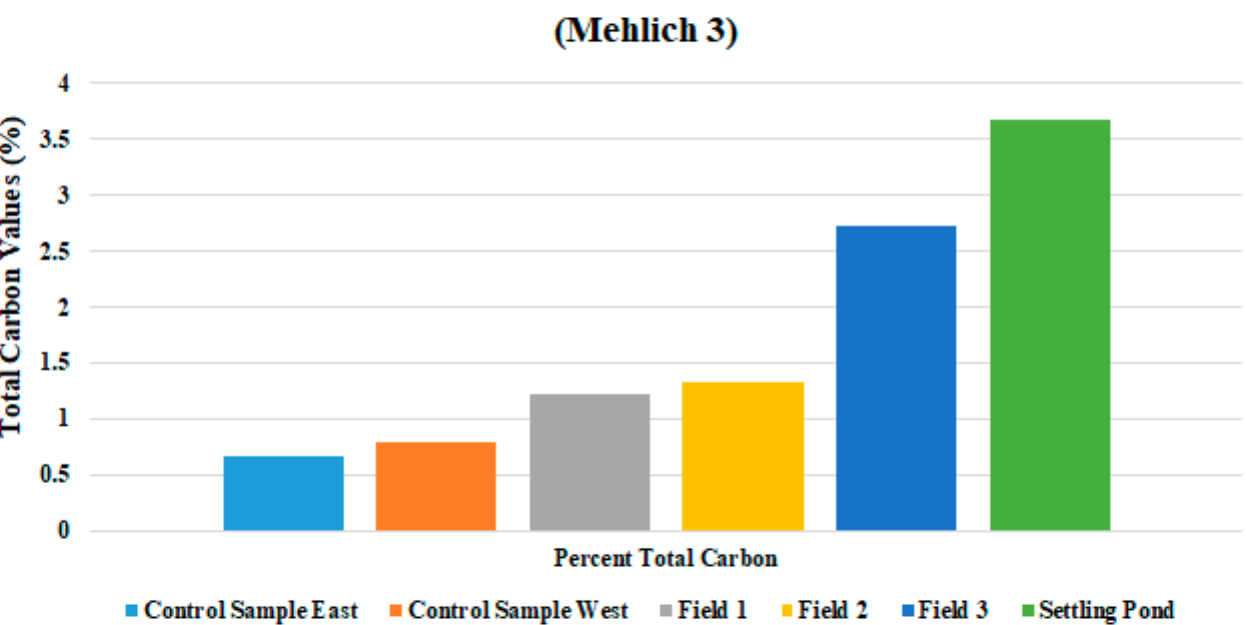
Figure 8. Mean total carbon levels for three fields and three sample ponds.